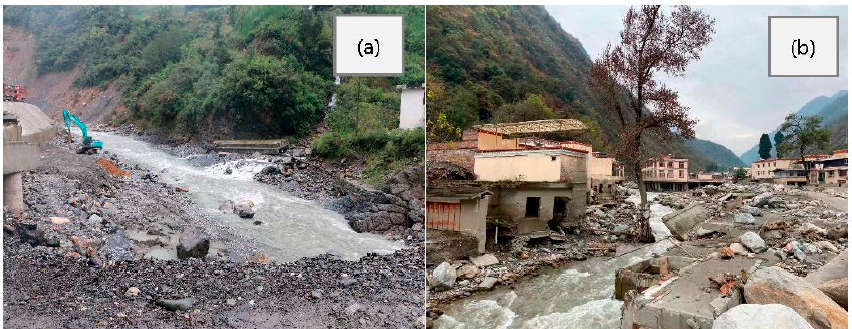
Figure 1. Flash flood on 20 August 2019 in Aba Prefecture, Sichuan. ( a ) The bridges were broken; ( b ) the houses were destroyed (photo taken by author).